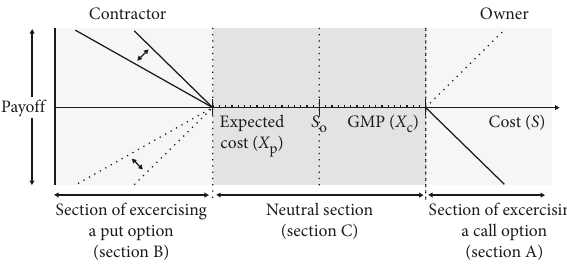
Figure 3: Valuation of the GMP contract based on the collar option